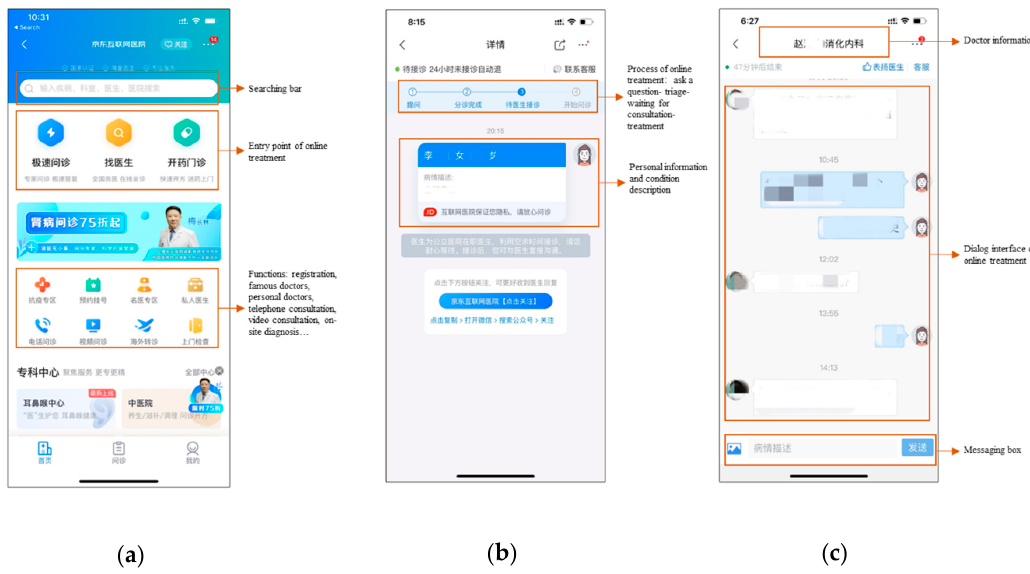
Figure 1. An example of an MMT application (Jingdong Health): ( a ) the home page; ( b ) the consultation waiting page; ( c ) the page for online treatment (https://app.jd.com/).